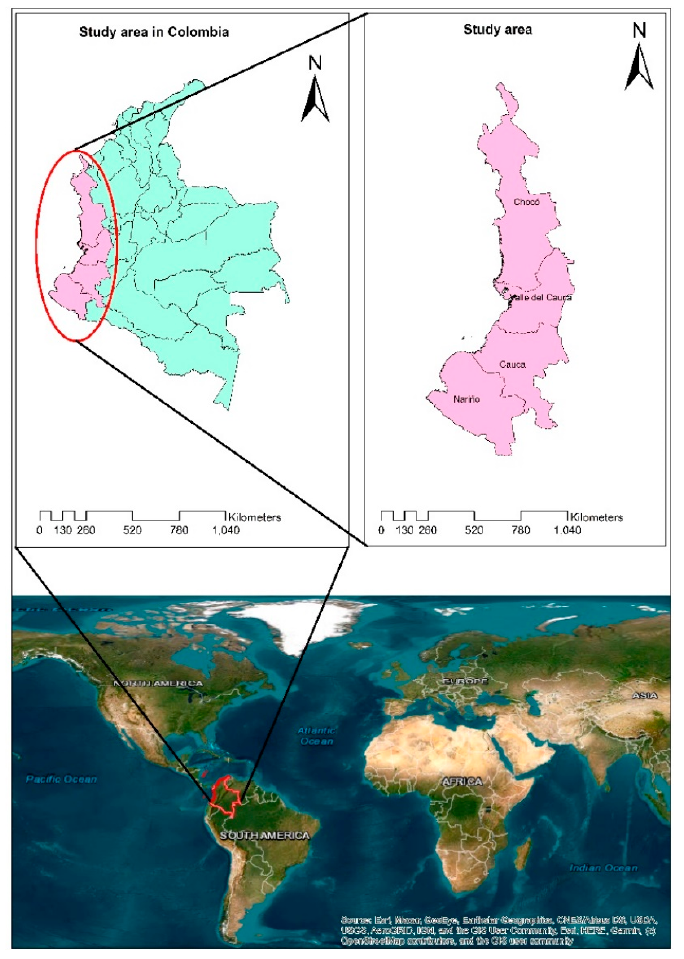
Figure 1. The study area: Colombia’s Pacific region (0.4° N–8° N, 75.9° W–78.9° W).